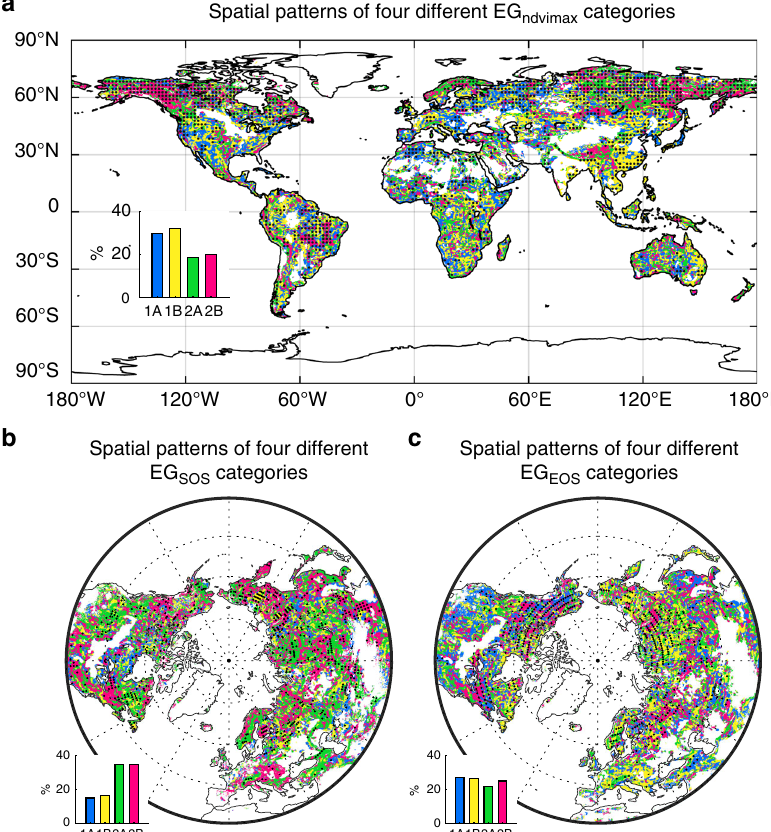
Fig. 4 Spatial patterns of different temporal trends of the elevational gradient (EG) of vegetation activities. a The spatial pattern of different categories of the temporal trends in EG ndvimax during 1982 – 2015. b The spatial pattern of different categories of the temporal trends in EG SOS during 1982 – 2011 over the Northern Hemisphere (north of 30 °N). c The spatial pattern of different categories of the temporal trends in EG EOS during 1982 – 2011 over the Northern Hemisphere (north of 30 °N). Category colors in this fi gure correspond to that shown in Fig. 3. Regions marked with dots have statistically signi fi cant ( p < 0.05 with the F -test) EG values. The area fraction of each of the four different categories in the temporal trends of EG ndvimax /EG SOS /EG EOS is shown in the inset at bottom-left for each